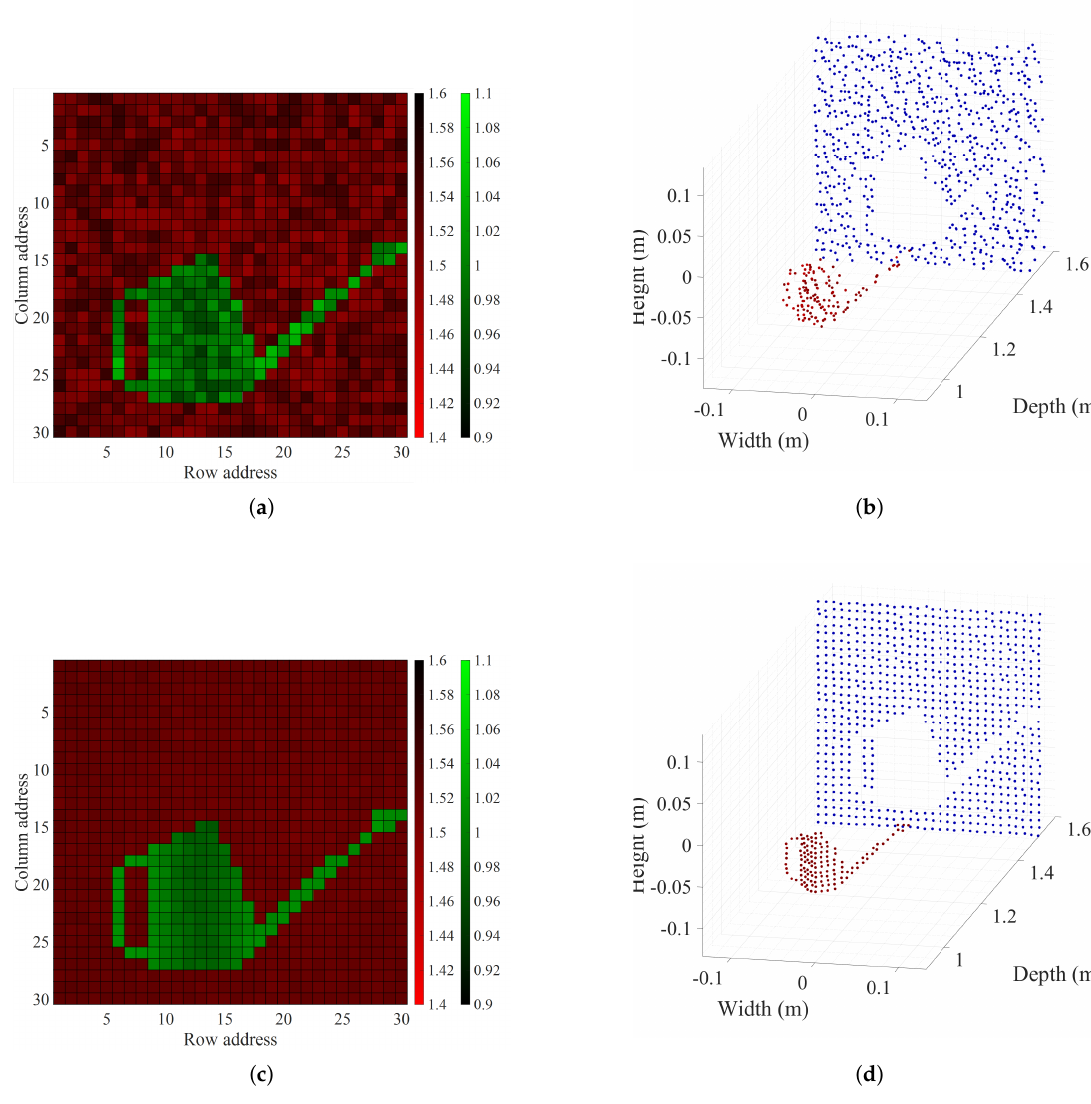
Figure 12. Measured results of the watering can and the black matter paper wall: ( a ) distance map and ( b ) point cloud image in the legacy mode; ( c ) distance map and ( d ) point cloud image in the OCDMA